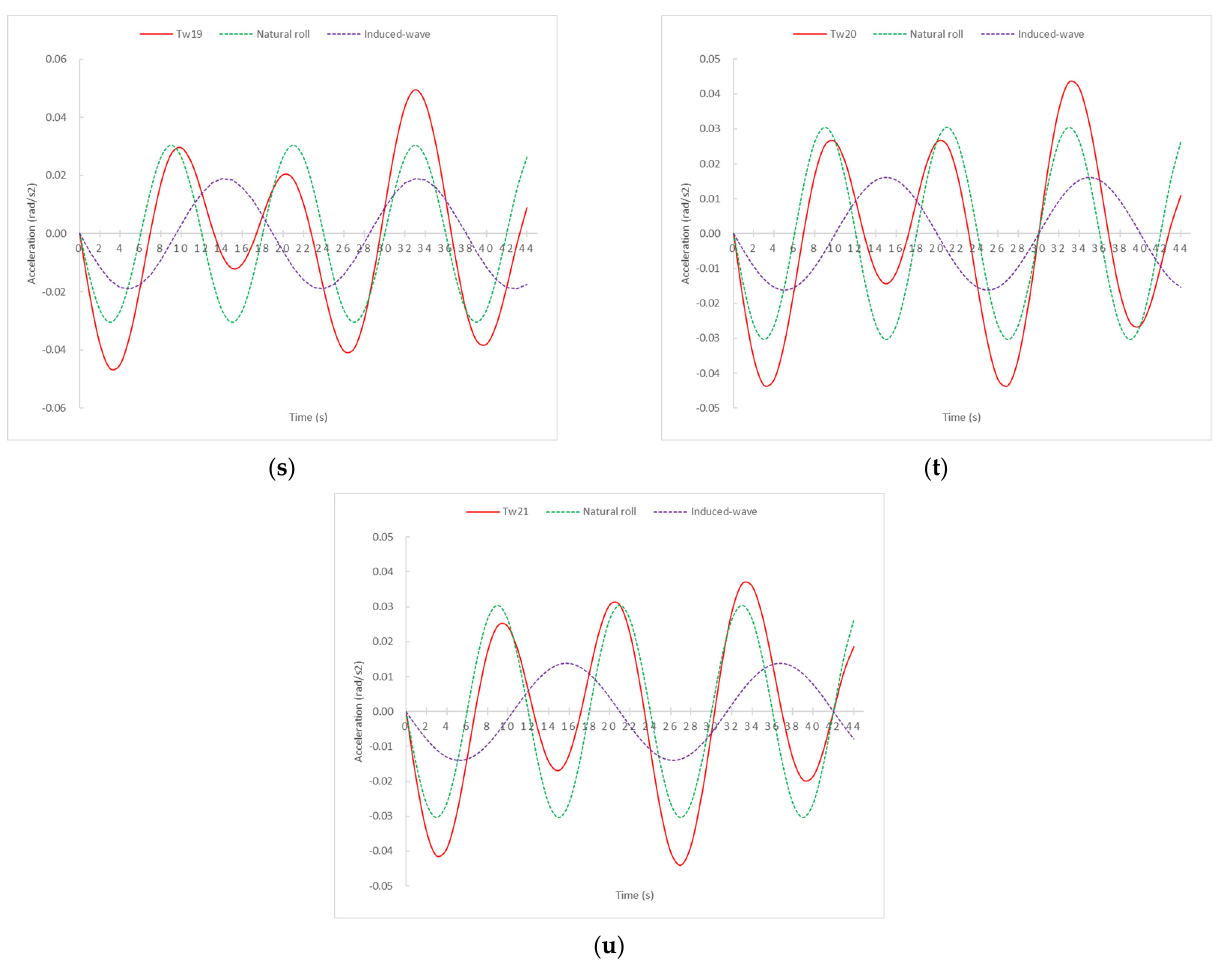
Figure 5. Total transverse accelerations (red lines) by 21 different swell conditions for a ship with a Td = 12 s broken down into the sum of ship’s natural roll (green lines) and the induce-wave roll (purple lines). ( a ) Tw= 1 s ( b ) Tw= 2 s ( c ) Tw= 3 s ( d ) Tw= 4 s ( e ) Tw= 5 s ( f ) Tw= 6 s ( g ) Tw= 7 s ( h ) Tw= 8 s ( i ) Tw= 9 s ( j ) Tw= 10 s ( k ) Tw= 11 s ( l ) Tw= 11.99 s ( m ) Tw= 13 s ( n ) Tw= 14 s ( o ) Tw= 15 s